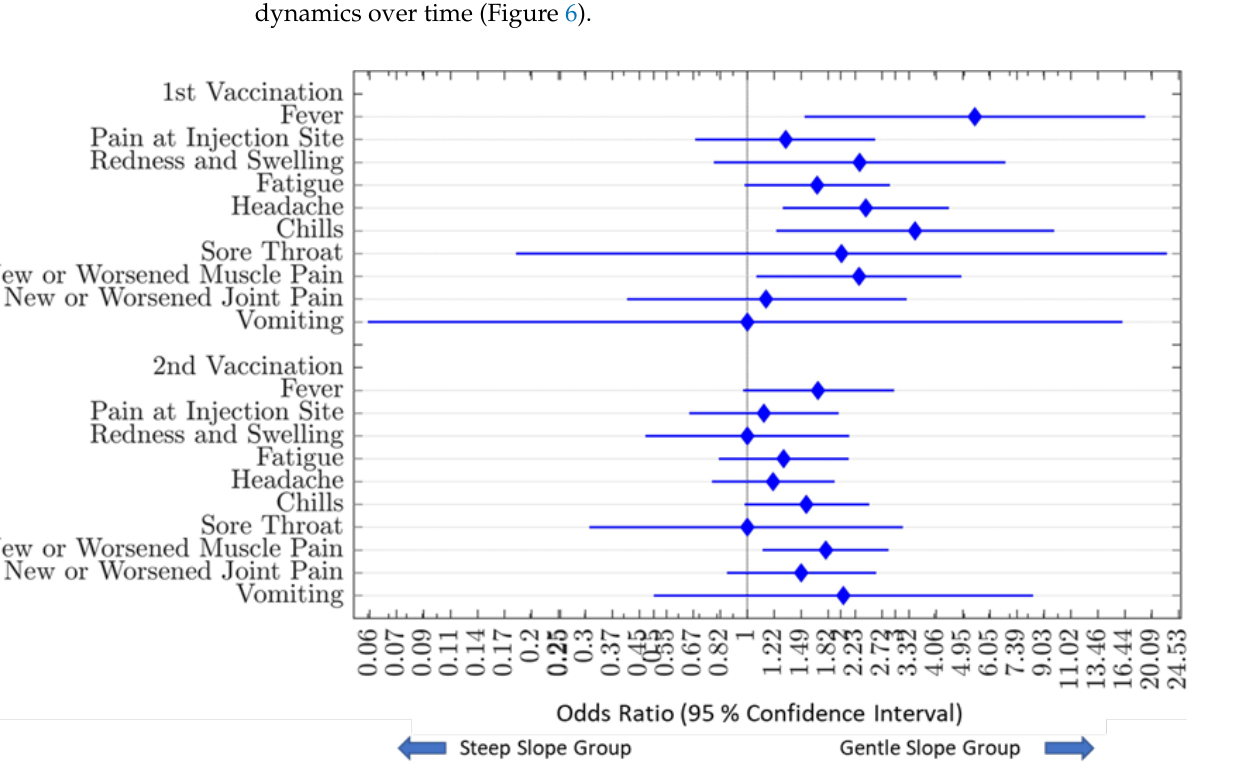
Figure 6. Association of Vaccine-Associated Adverse Events on Antibody Decay. Amongst all study subjects, the incidence of vaccine-associated adverse events between the gentle slope group (n = 148) and the steep slope group (n = 148) were compared. Those in the gentle slope group were significantly more likely to have fever (OR = 5.41), headache (OR = 2.41), chills (OR = 3.47), and new or worsening muscle aches (OR = 2.29) after the 1st vaccination and have new or worsening muscle aches (OR = 1.79) after the second vaccination. Blue diamonds represent the odds ratio of having reporting vaccine-associated adverse events. Bars to the left and right of each blue diamond represent the upper and lower confidence intervals.